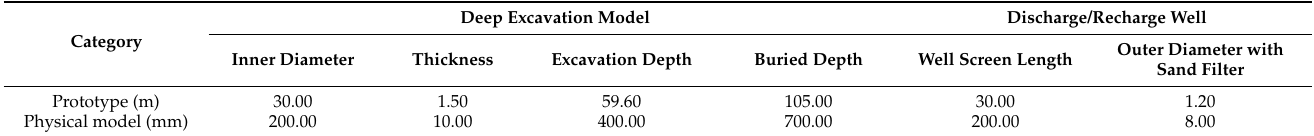
Table 4. Similar parameters of underground structure